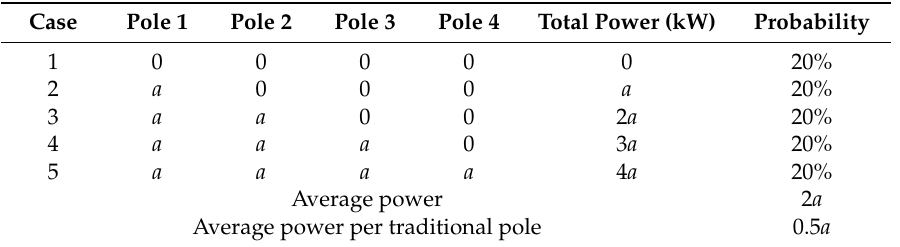
Table 3. Average power of 4 traditional poles under the condition of uniform